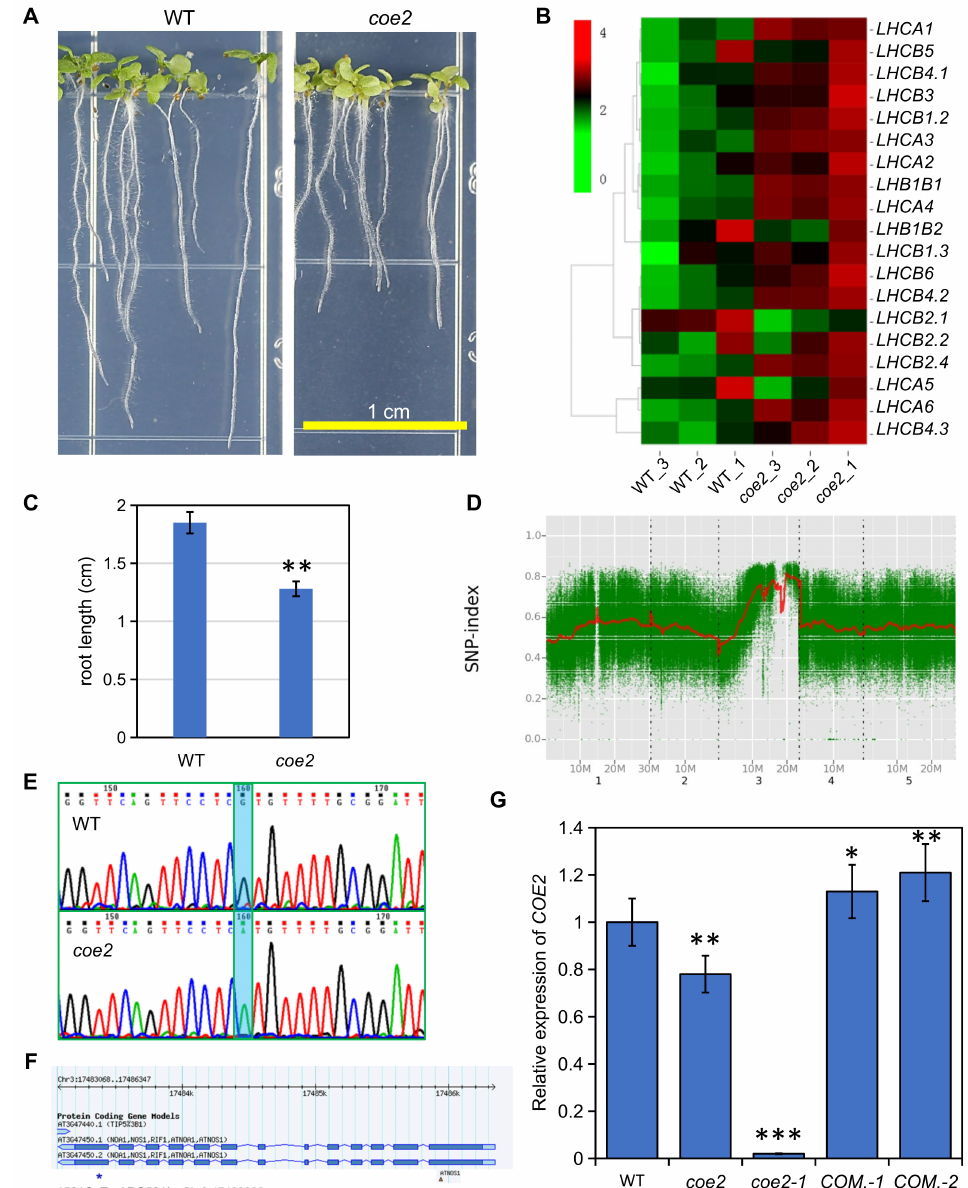
Figure 1. Identification of coe2 mutant. ( A ) Phenotype of 5-day-old seedlings of coe2 and WT on 1/2 MS plates. ( B ) Heatmap of the expression of genes of light-harvesting proteins in cotyledons of seedlings of coe2 and WT under normal growth conditions. ( C ) Statistical analysis of the root length in 5-day-old seedlings of WT and coe2 . Three biological replications were used. The student’s t -test of coe2 versus WT, ** p < 0.001. ( D ) The SNP-index of coe2 . SNPs between coe2 and the reference genome were analyzed by Bulked Segregant Analysis. ( E ) The candidate mutation of coe2 was identified by DNA sequencing. ( F ) The mutation of coe2 (blue star) and coe2-1 (triangle, SALK_047882) are marked on the gene map. ( G ) Relative expression of COE2 in coe2 , coe2-1 , and WT was determined by qPCR. Three biological replicates were used. The student’s t -test of coe2 or COM. Versus WT, * p < 0.05%, ** p < 0.01%, *** p <